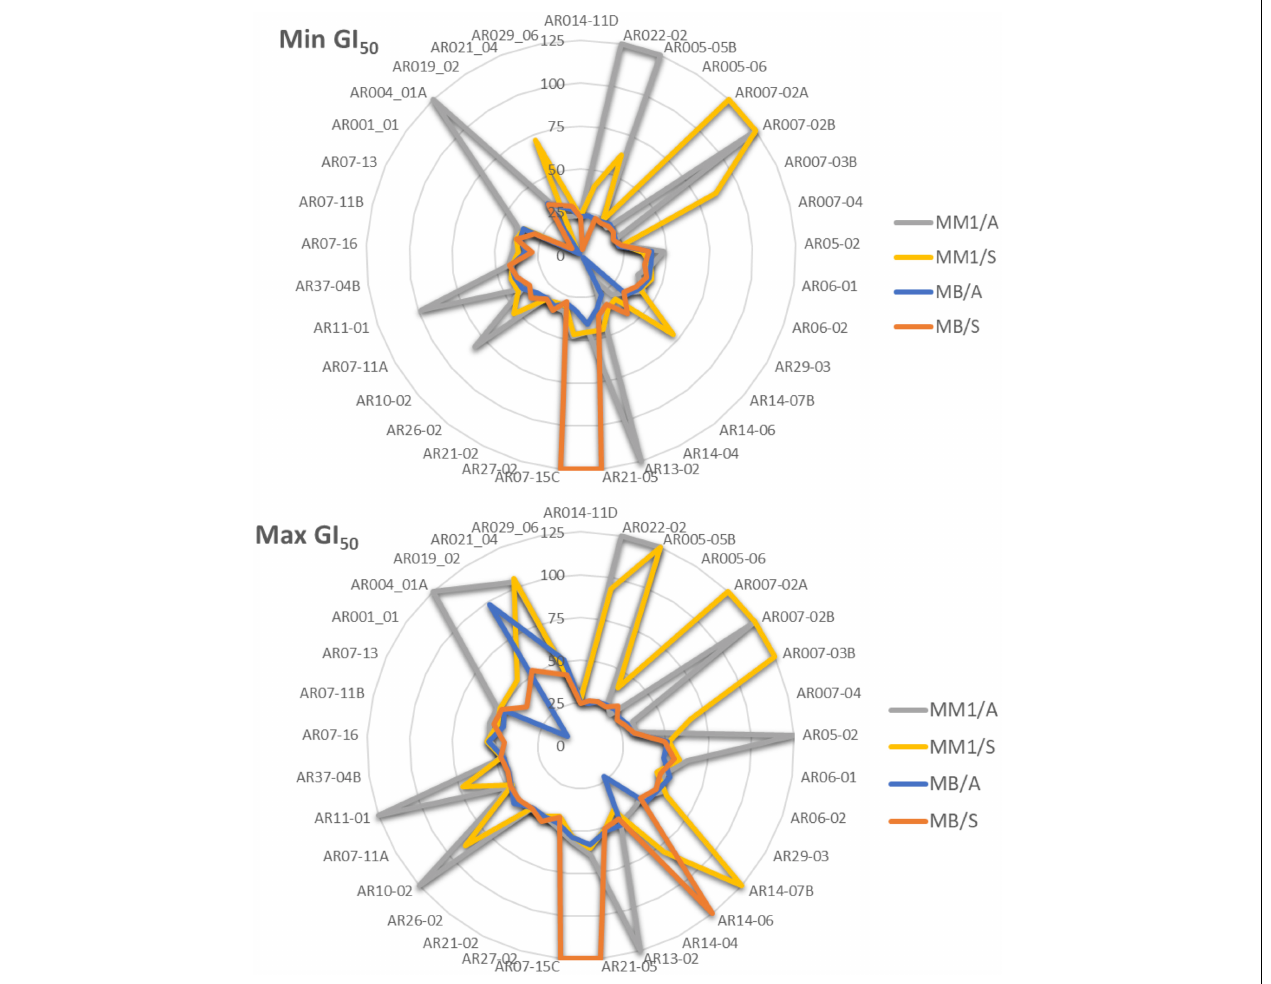
FIGURE 6 | Radar chart of the effect of culture conditions in the antiproliferative activity (Min and Max GI 50 , µ g/mL). MB and MM1 media were diluted in a 1:5 ratio for oligotrophic conditions. A, agitation conditions; S, static cultures.